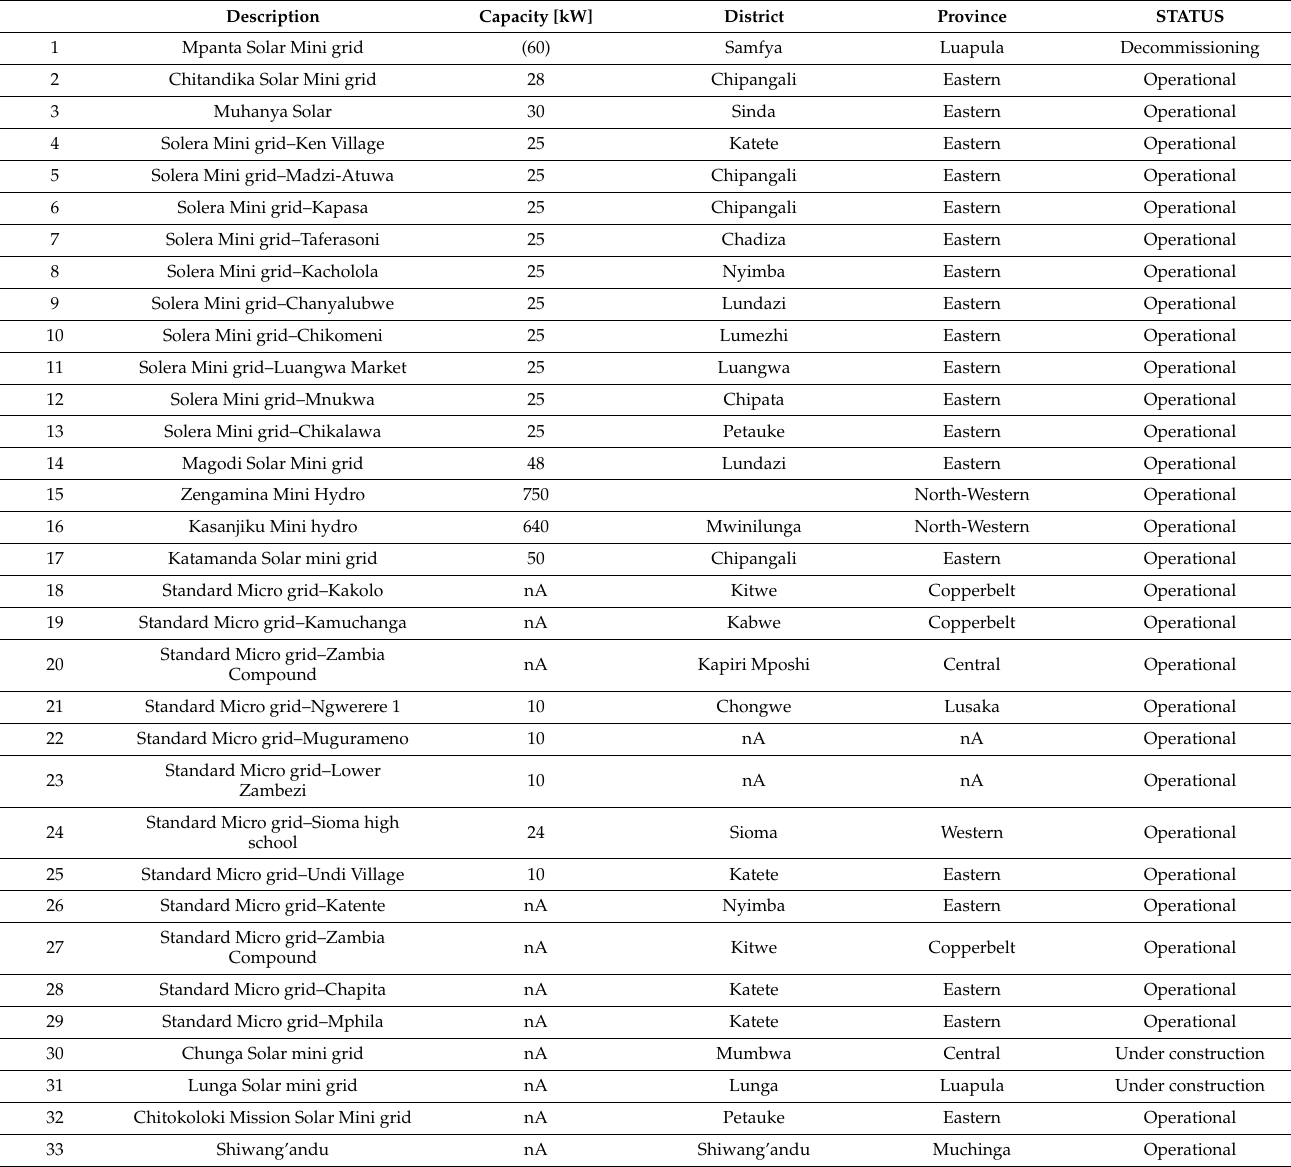
Table A3. List of RE Mini-grids in Zambia (Source: UNZA research in cooperation with REA).